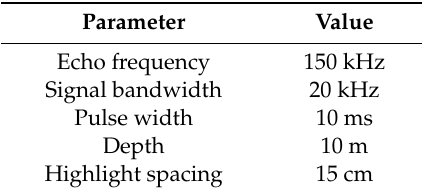
Table 1. Transducer array and target parameters